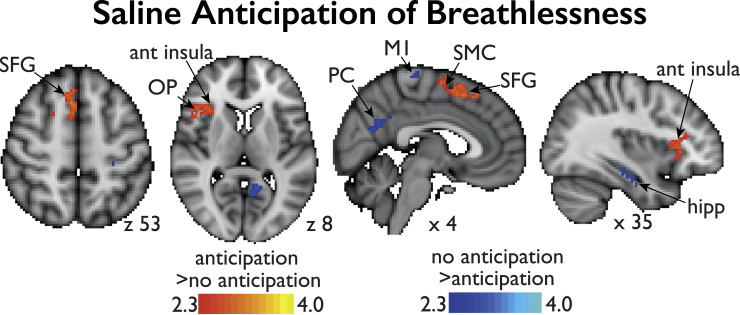
BOLD activation contrasting anticipation of breathlessness with anticipation of no loading during saline administration. The image consists of a color-rendered statistical map superimposed on a standard (MNI) brain. Significant regions are displayed with a threshold of Z>2.3 with a cluster probability threshold of p<0.05 (corrected for multiple comparisons). Abbreviations: ant insula, anterior insula; OP, opercular-frontal cortex (operculum); SMC, supplementary motor cortex; SFG, superior frontal gyrus; PC, precuneus; hipp, hippocampus; M1, primary motor cortex. No significant reductions in anticipation of loading were observed with the administration of remifentanil (not shown).